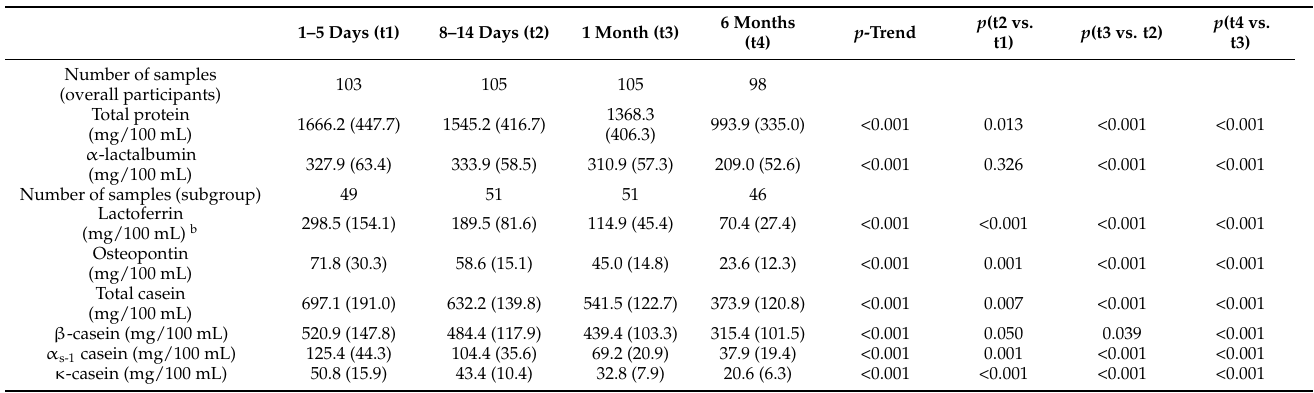
Table 2. Concentration of human milk proteins during the first six months of lactation a